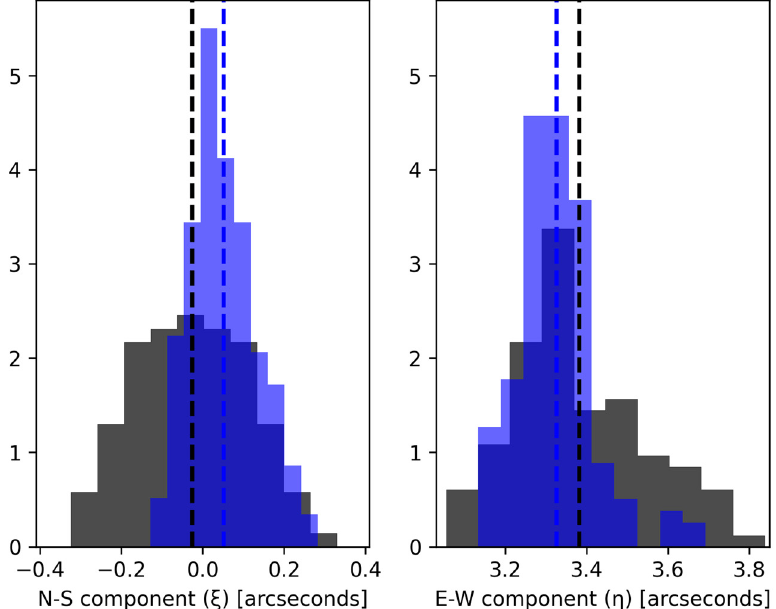
Figure 7. Histogram of VESTA (grey) and CODIAC Blue and Red (blue) measurement results ( ξ , η ) obtained during the campaign. Dashed vertical lines represent corresponding mean value.